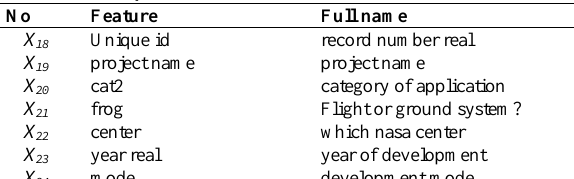
Full name Feature No